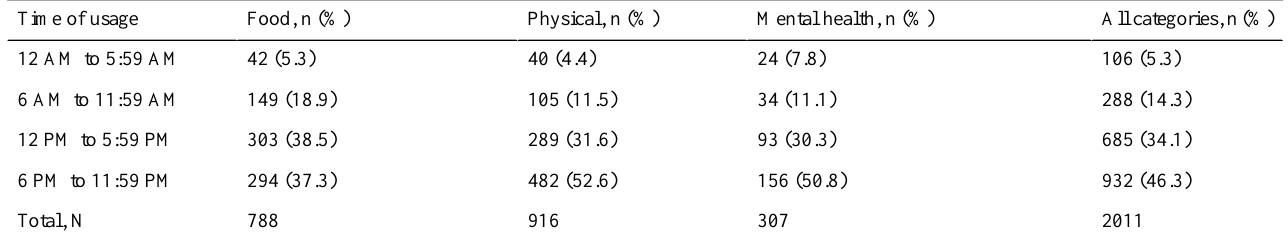
Table 3. Times of day spent on each exercise